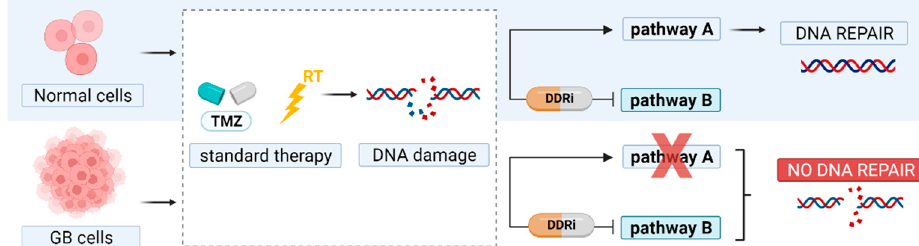
Figure 1. Principle of synthetic lethality. In glioblastoma (GB) therapy, DNA damage is induced by temozolomide (TMZ) and radiation therapy (RT). DNA repair pathways are often disrupted (pathway A) and therefore GB cells solely depend on a back-up pathway to repair DNA damage. Inhibitors of essential DNA damage response kinases (DDRi) can block this rescue pathway to promote GB cell death.